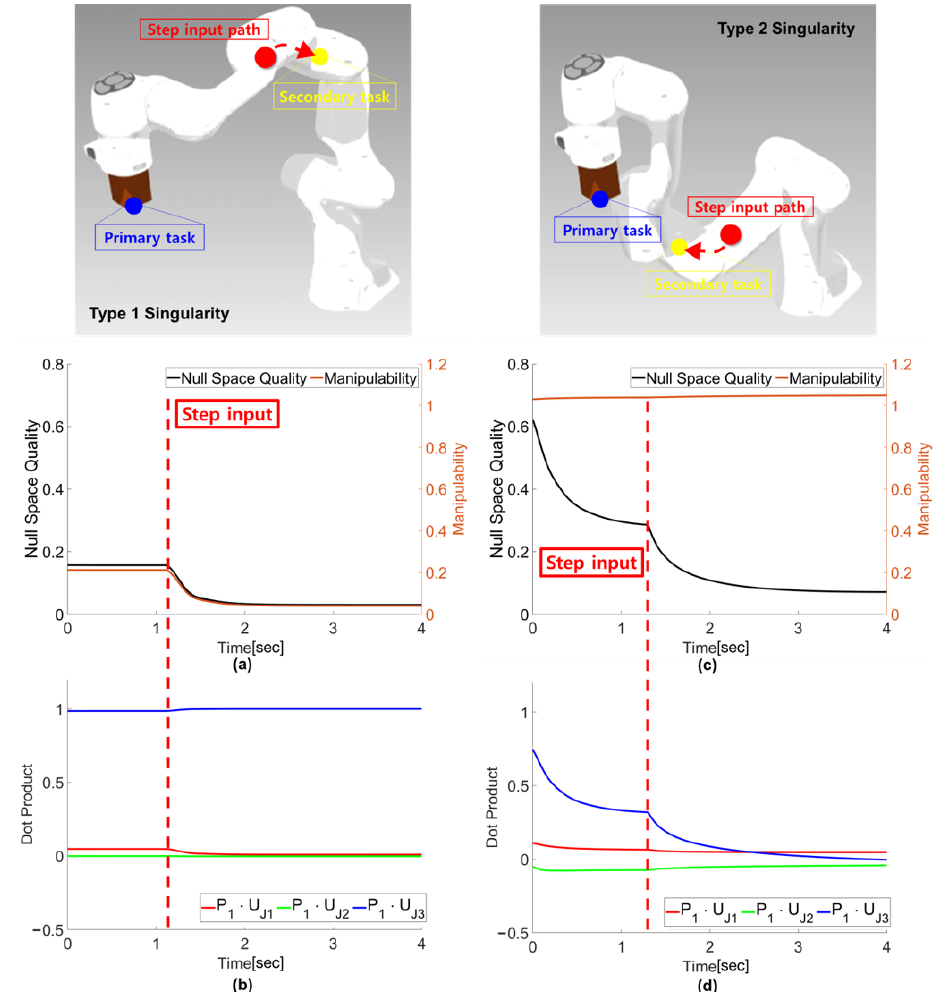
Figure 3. The two types of singular state configurations are shown. ( a ) shows the null space quality vs. the manipulability of a manipulator when the manipulator moves to the type 1 singular state by the step input. Type 1 singularity is caused by the Jacobian, which reflects the kinematics of the controlled body. ( b ) shows the dot product between the joint basis of the null space projector and the Jacobian of the secondary task. The nonzero dot product subset of the joint bases of Jacobian forms the bases after the projection. The dot product is the dimensionless value. ( c ) shows the type 2 singular state caused by the joint constraints. ( d ) shows that the dot product of every vector is nearly zero after the step input. This implies that the presence of subset of joint bases that forms the bases in the null space is